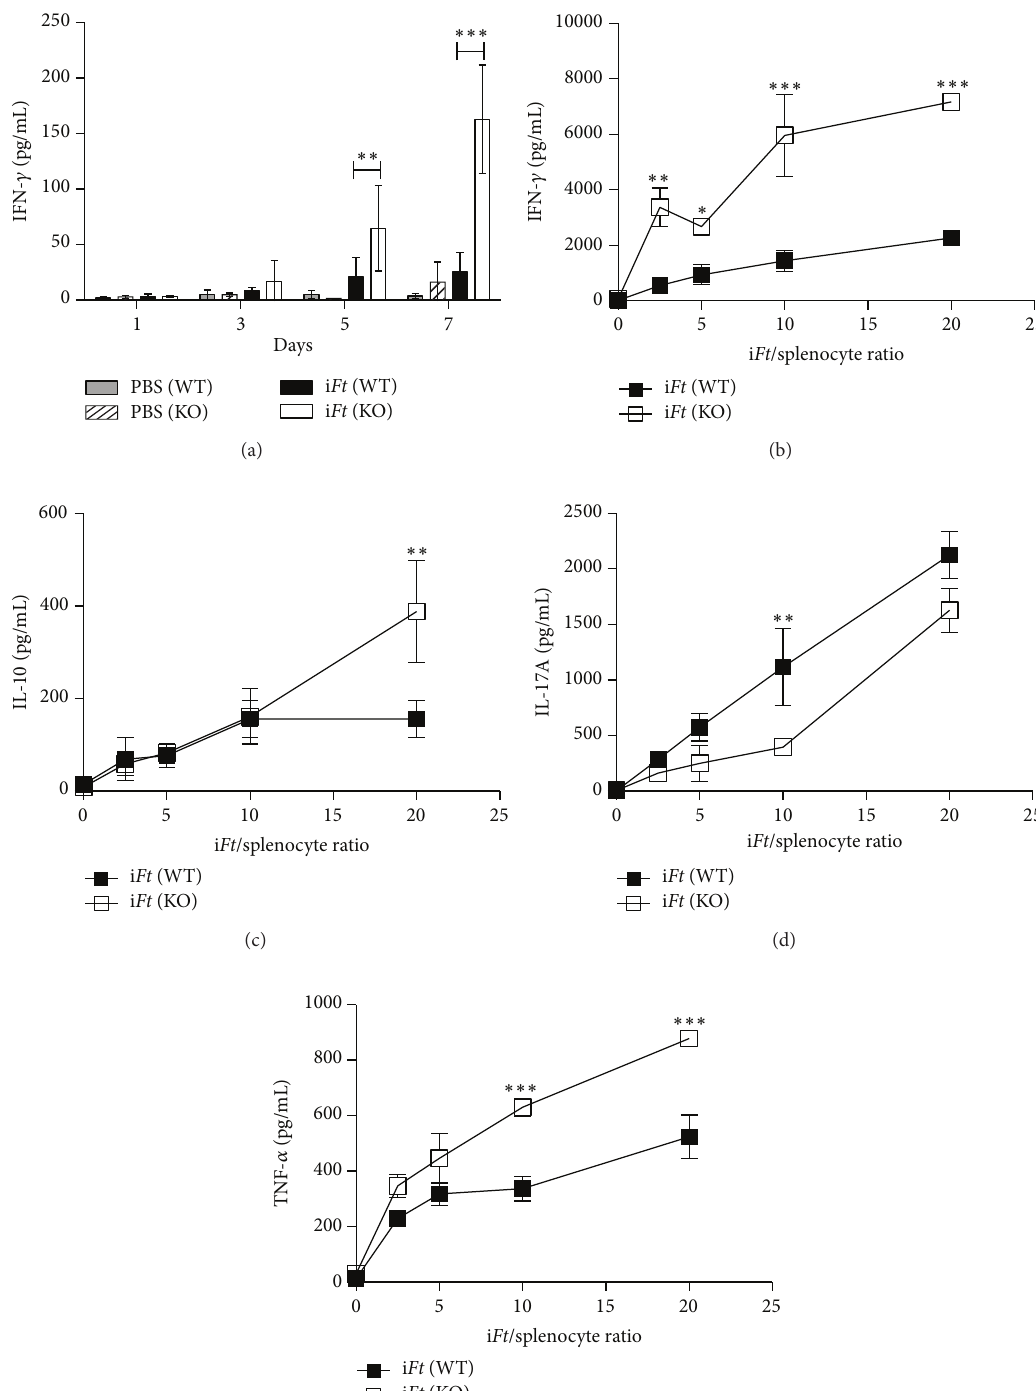
Figure 4: Splenocytes from i Ft -immunized Fc 𝛾 RIIB KO versus WT mice exhibit enhanced IFN- 𝛾 , IL-10, and TNF- 𝛼 production in response to i Ft added ex vivo . WT C57BL/6J and Fc 𝛾 RIIB KO mice were immunized i.n. with 20 𝜇 L of PBS (vehicle) or 2 × 10 7 i Ft -organisms in 20 𝜇 L of PBS on day 0 and boosted on day 21. (a) Splenocytes were then harvested from individual mice on day 35 and stimulated at a ratio of one i Ft per splenocyte. Supernatants were then harvested at the indicated days. (b) Fc 𝛾 RIIB KO and WT mice were immunized and splenocytes were harvested as previously described. Splenocytes were then stimulated at increasing i Ft to splenocyte ratios. Supernatants were harvested five days later and analyzed for IFN- 𝛾 , (c) IL-10, (d) IL-17A, and (e) TNF- 𝛼 via CBA assay. A two-way ANOVA and a Bonferroni posttest